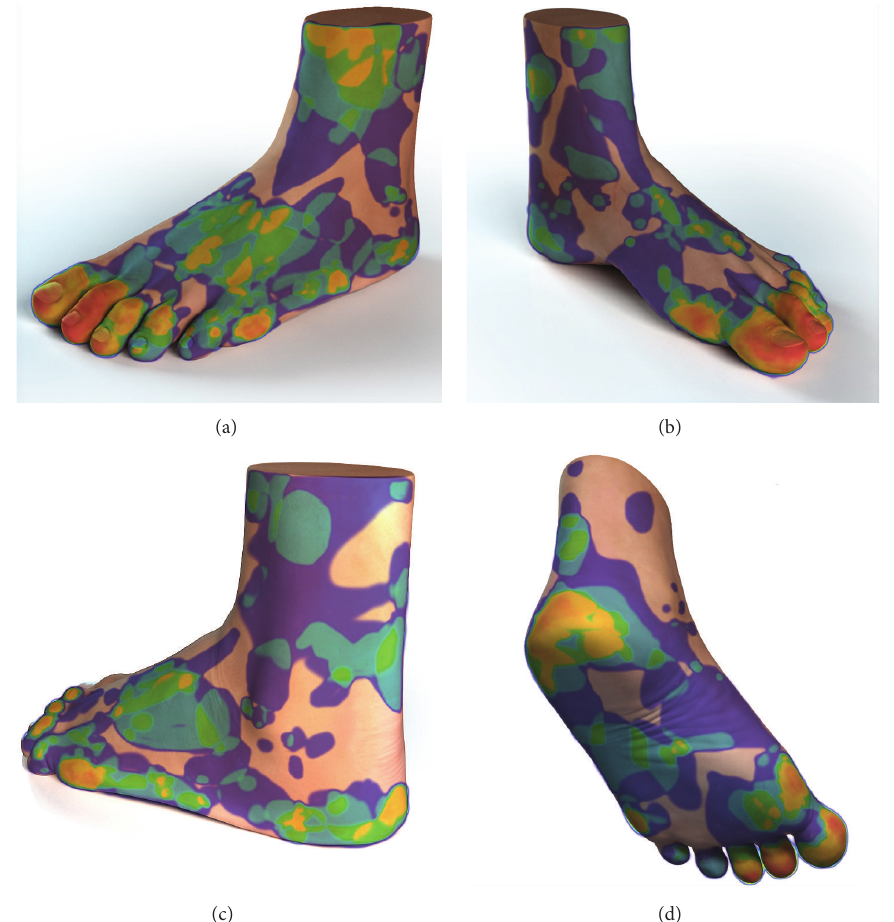
Figure 1: Composite image of all wounds showing predisposing areas. Likelihood to contain wounds varies from red (most likely) to blue (least